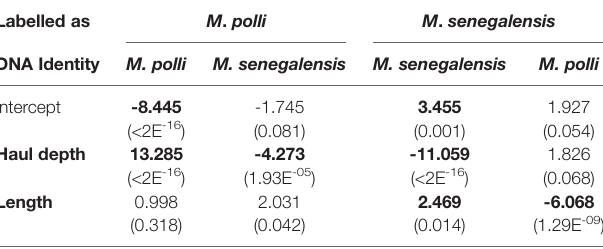
Signi fi cant z-values appear in bold (p-value in